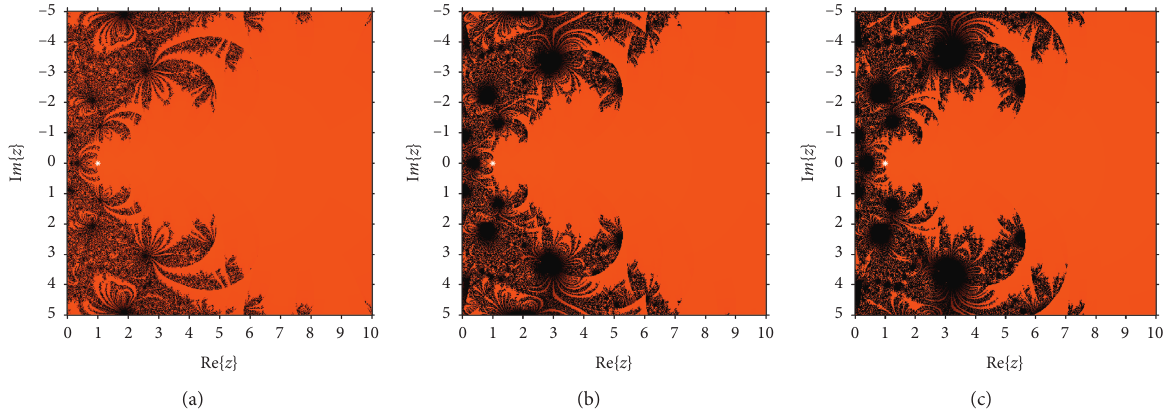
Figure 9: Basins of attraction of (a) BM1, (b) AM2, and (c) ZM3 for g